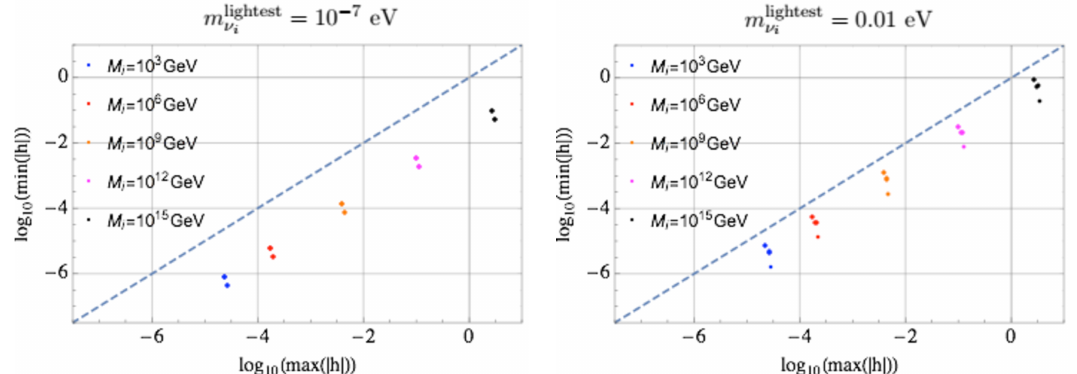
Figure 5 . Case M i > Λ i : same as figure 4, for the loop-induced neutrino mass in eq. (3.38) for ETC and FPC case, and in eq. (3.39) for PC case where M i are replaced by m a